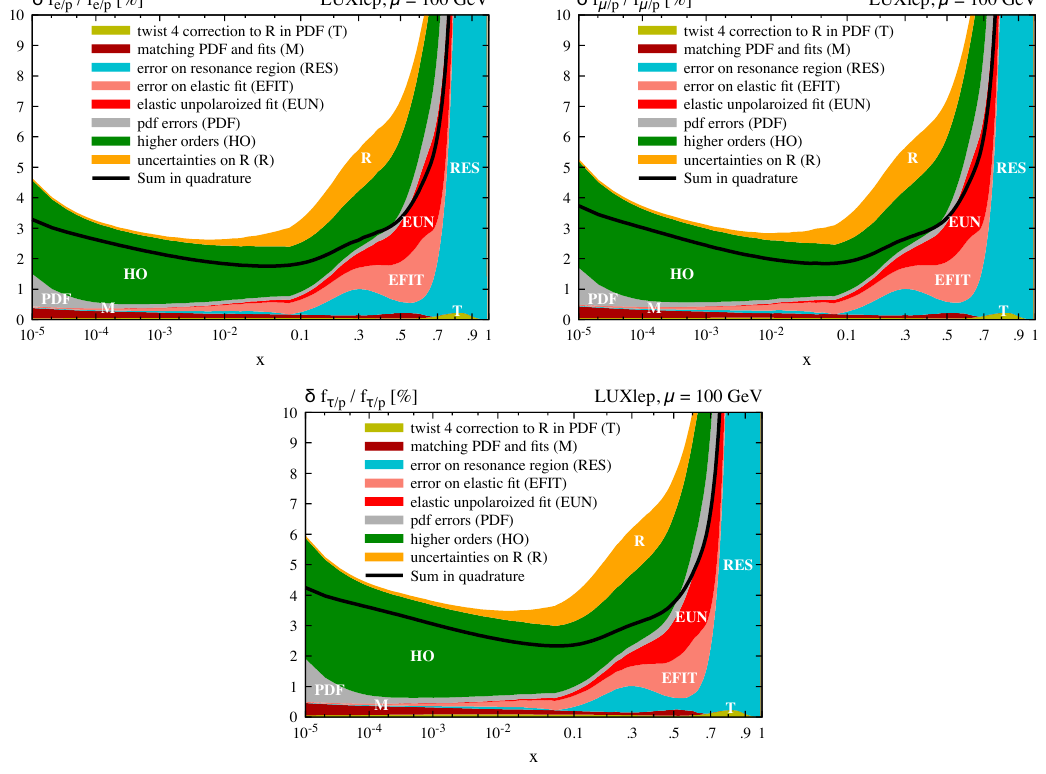
Figure 3. As in (cid:12)gure 2 for the electron (top left), for the muon (top right) and for the tau (bottom).